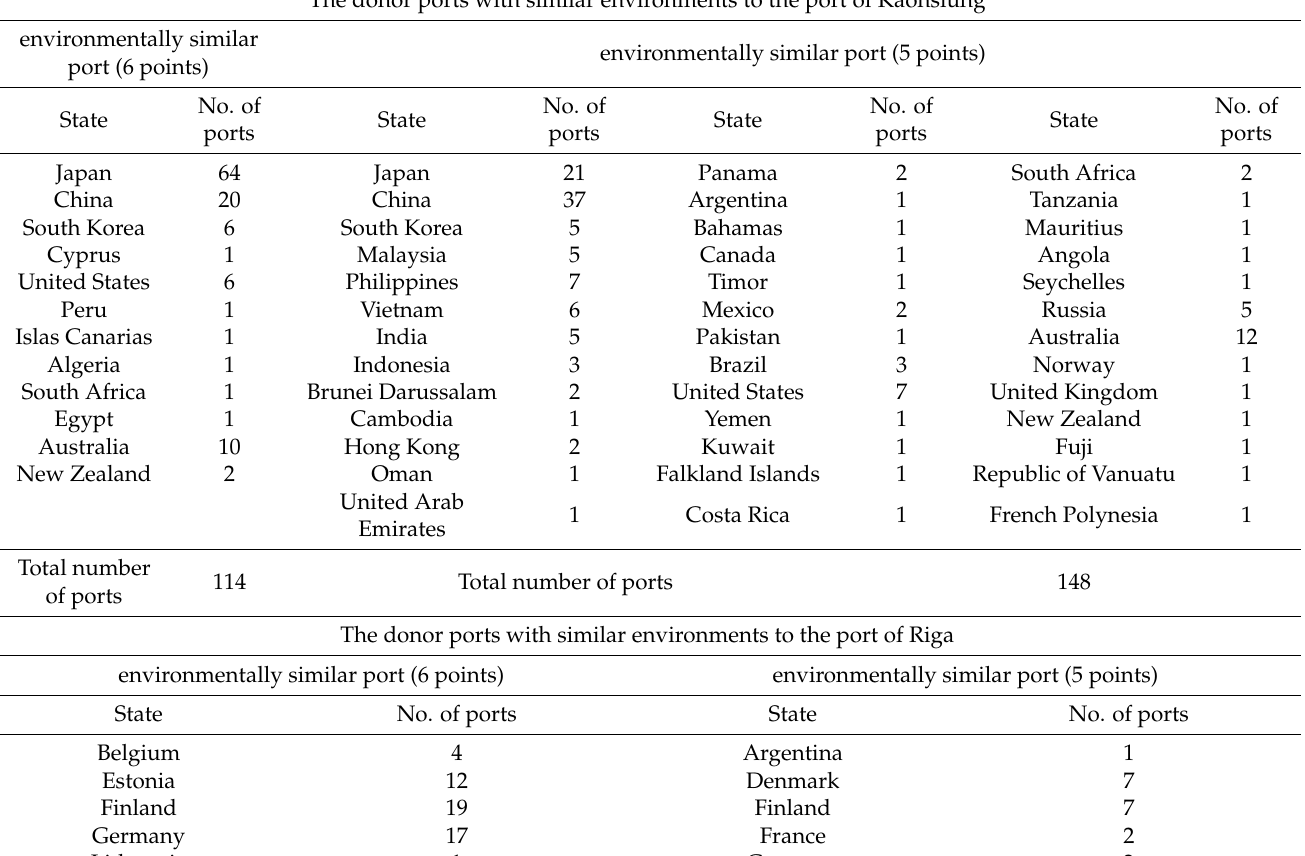
Table 4. Donor ports with similar environments to the ports of Kaohsiung and